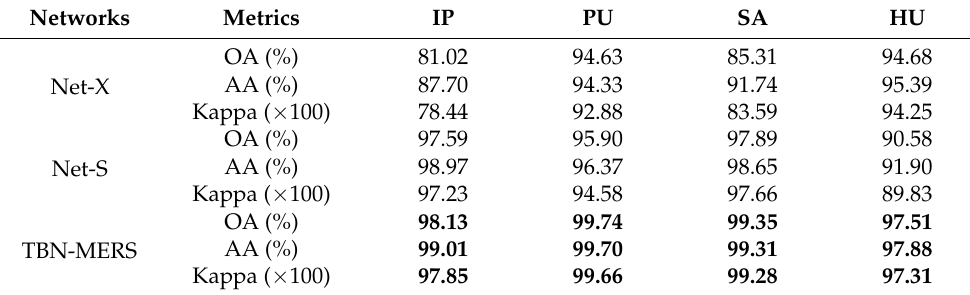
Table 6. Classification results of Net-X, Net-S, and